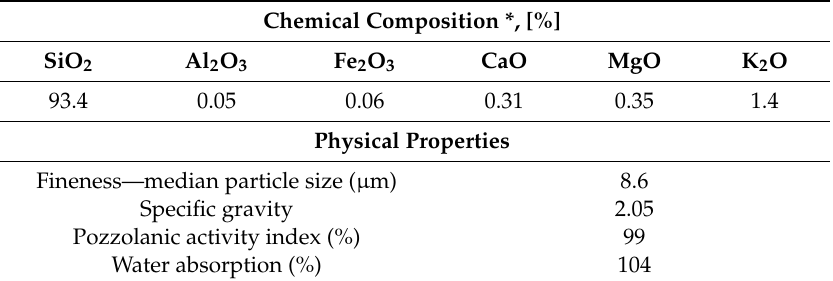
Table 5. Typical chemical and physical properties of Rice Husk Ash (RHA)